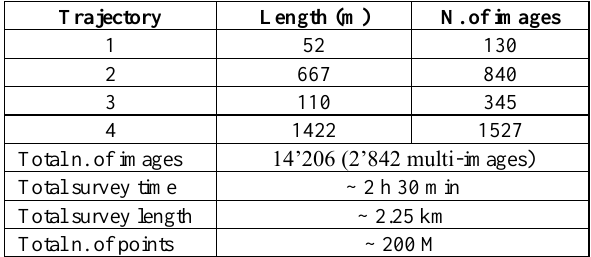
Table 3 . Details of the 4 trajectories acquired with